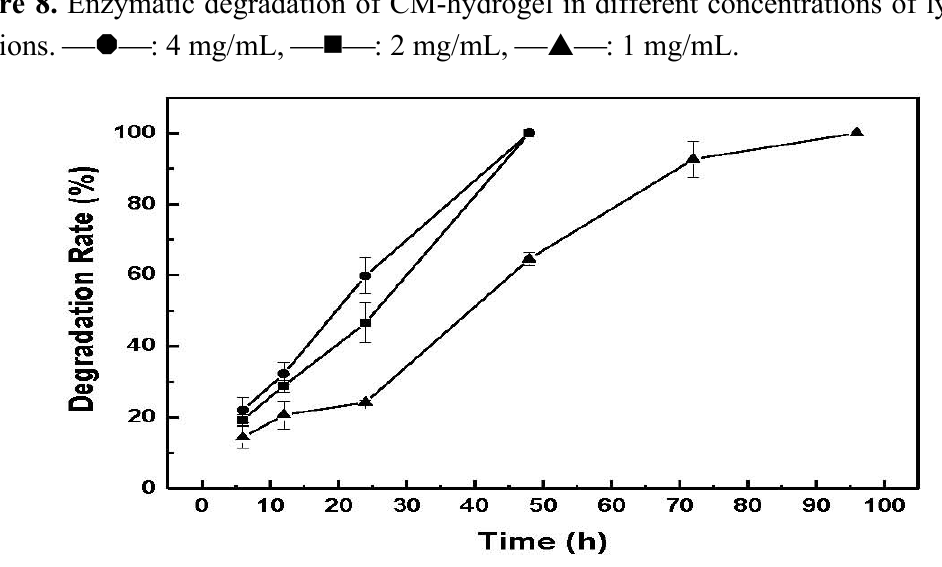
Figure 8. Enzymatic degradation of CM-hydrogel in different concentrations of